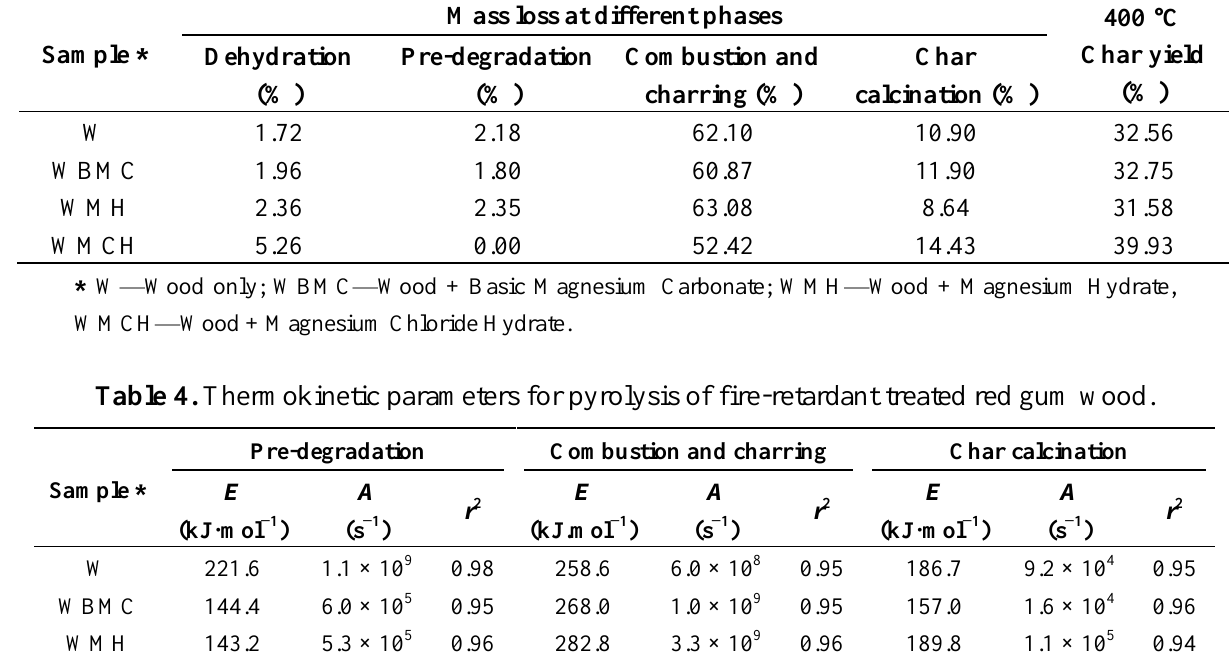
Table 3. Mass losses and char yield of wood component in the treated red gum wood sample. Sample *